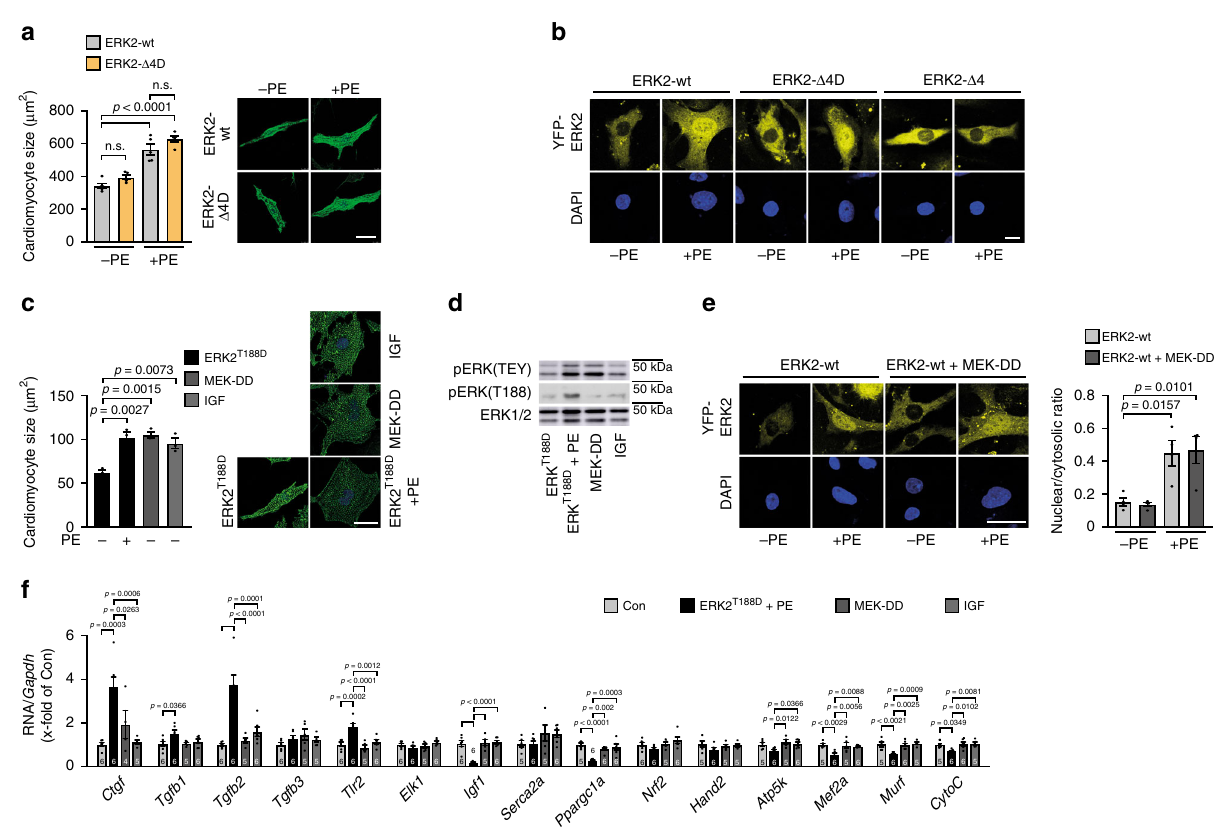
Fig. 2 Nuclear ERK2 accumulation requires ERK T188 -phosphorylation and impacts on hypertrophic gene regulation. a Images and quanti fi cation of cell size of phalloidin-stained NRCM transduced with Flag-tagged ERK2-wt or Flag-ERK2 Δ 174 – 177,T188D (ERK2- Δ 4D) in response to PE (4 µ M, 24 h) ( n = 5 independent experiments and 25 cells per group and experiment; scale bar 20 µ m). b Nuclear-to-cytosolic ratios of YFP-tagged ERK2-wt (ERK2-wt), YFP- ERK2 Δ 174 – 177 (ERK2- Δ 4), and YFP-ERK2 Δ 174 – 177,T188D (ERK2- Δ 4D) in NRCM in response to PE (4 µ M, 10 min). Shown are confocal images displaying distribution of YFP-tagged ERK2 constructs (yellow) and DAPI-stained cell nuclei (blue) (scale bar 10 µ m). Quanti fi cation: Supplementary Fig. 4A. c , d NRCM transduced with Flag-tagged ERK2 T188D (ERK2 T188D ) or HA-tagged MEK1 SS218/222DD (MEK-DD) treated with PE (4 µ M, 24 h) or IGF (30pM, 24 h). c Representative phalloidin-stained NRCM (scale bar 25 µ m) and cell size analysis ( n = 3 independent experiments and 70 – 100 cells per group and experiment). d Representative western blots of pERK(TEY) and pERK(T188) were reproduced three times with similar results. e Nuclear-to-cytosolic ratios of NRCM transduced with YFP-tagged ERK2-wt and MEK-DD if indicated and stimulated with PE (4 µ M, 10 min). Shown are confocal images of YFP-ERK2, DAPI-stained cell nuclei (scale bar 10 µ m), and quantitative analyses ( n = 30 – 70 cells per group of four independent experiments). f NRCM transduced with Flag-tagged ERK2 T188D or the HA-tagged MEK1 SS218/222DD mutant treated with PE (4 µ M, 24 h) or IGF (30pM, 24 h). mRNA expression of connective tissue growth factor ( Ctgf ), transforming growth factor β 1 ( Tgfb1 ), transforming growth factor β 2 ( Tgfb2 ), transforming growth factor β 3 ( Tgfb3 ), Toll-like receptor2 ( Tlr2 ), ETS domain-containing protein Elk-1 ( Elk1 ), insulin-like growth factor ( Igf1 ), sarcoplasmic reticulum calcium ATPase 2A ( Serca2a ), peroxisome proliferator-activated receptor gamma coactivator 1- α ( Ppargc1a ), nuclear factor erythroid 2-related factor 2 ( Nrf2 ), heart- and neural crest derivatives-expressed protein 2 ( Hand2 ), ATP synthase, H + -transporting, mitochondrial F1F0 complex, subunit E ( Atp5k ), myocyte-speci fi c enhancer factor 2A ( Mef2a ), E3 ubiquitin-protein ligase TRIM63 ( Murf ), and cytochrome C ( CytoC ) normalized to glycerinaldehyde-3-phosphate dehydrogenase ( Gapdh ). n represents number of samples of biologically independent experiments measured in triplicates and are indicated in bar graph. Error bars are mean ±s.e.m.; ordinary one-way ANOVA with Tukey as post hoc test was used except for a where Bonferroni was used as post hoc test. Source data are provided as a Source Data fi